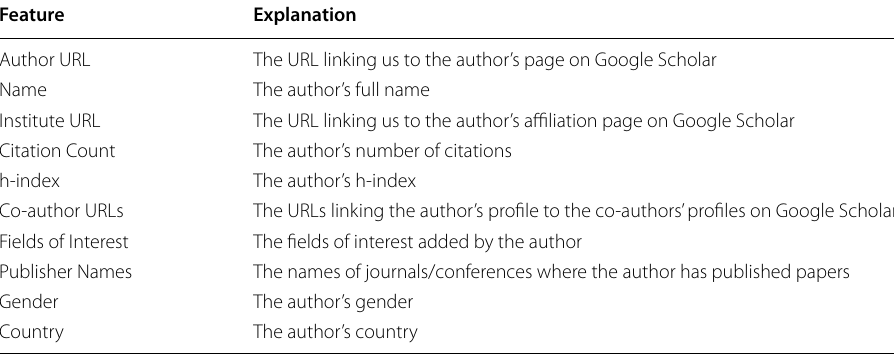
Table 1 The dataset features and their